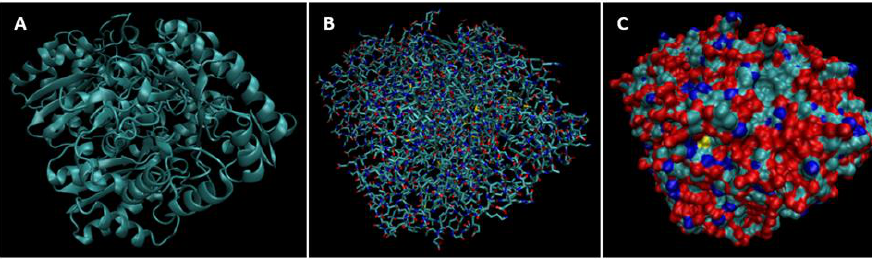
Figure 18. ( A ) A cartoon model, ( B ) a bonds model, and ( C ) a surface model of NSE.